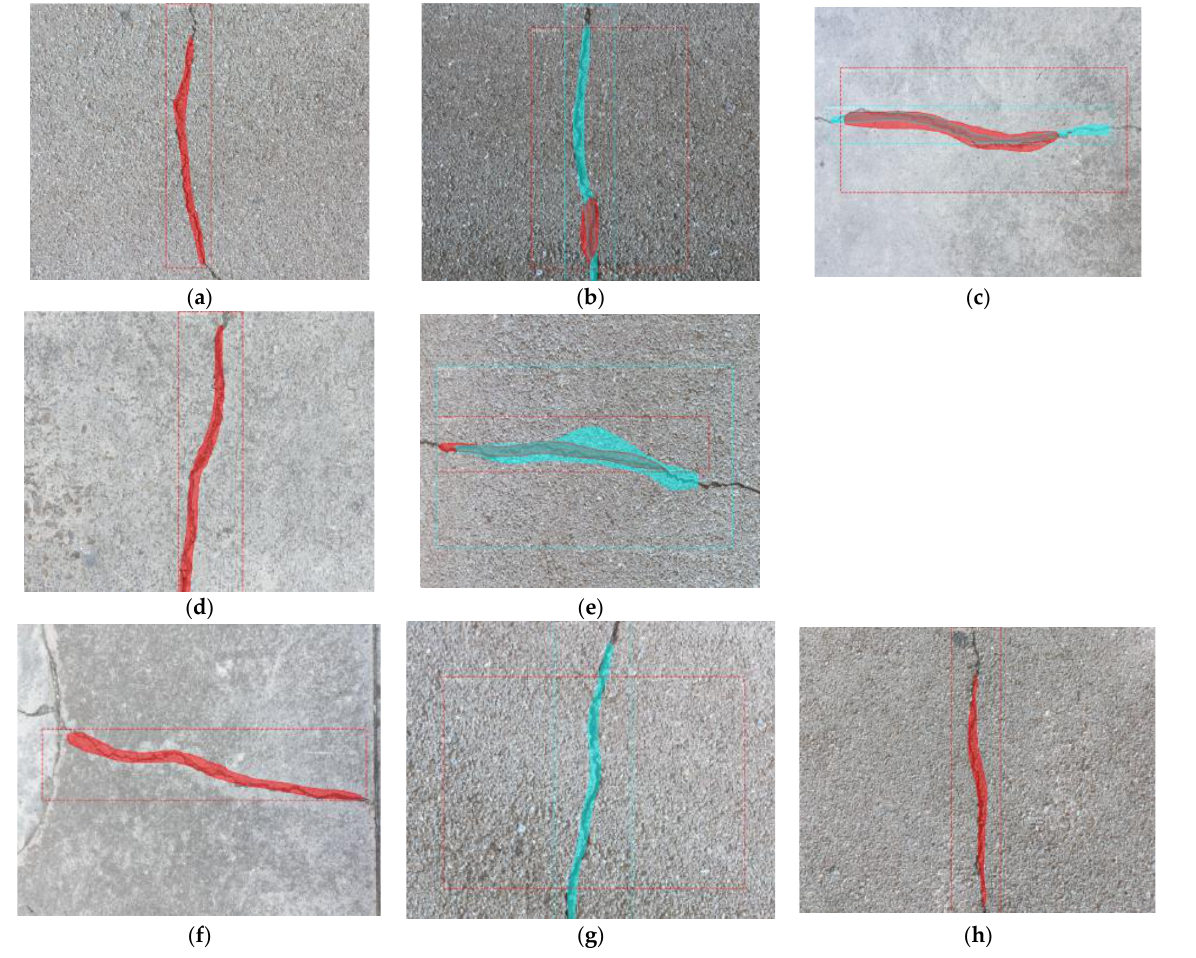
Figure 8. Recognition results for pavement cracks after optimization. ( a ) Confidence level: 95.0%; ( b ) Confidence level: 98.5%; ( c ) Confidence level: 93.2%; ( d ) Confidence level: 97.4%; ( e ) Confidence level: 92.9%; ( f ) Confidence level: 94.3%; ( g ) Confidence level: 91.7%; ( h ) Confidence level: 90.3%.